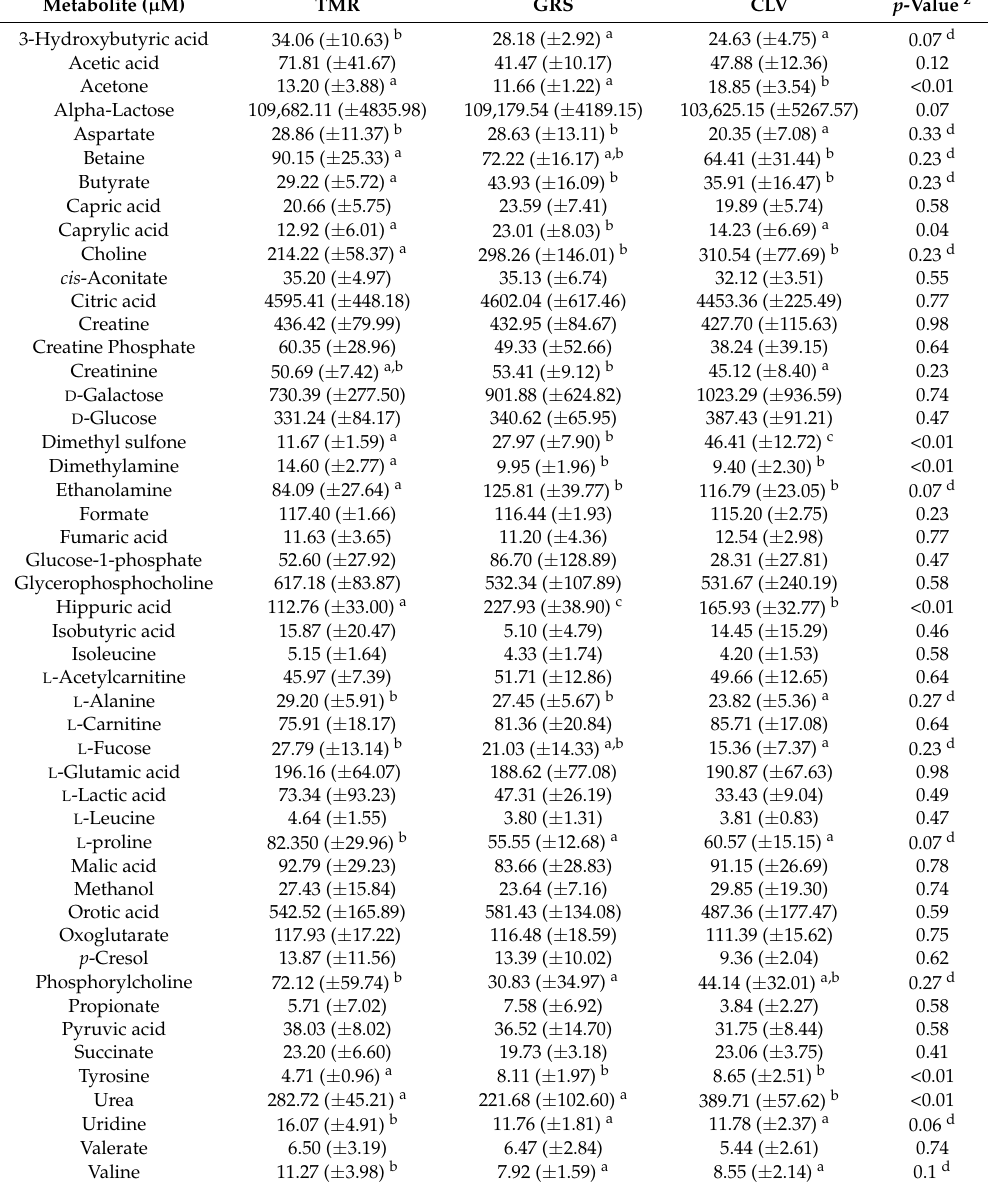
Table 5. Average concentrations (Mean ± standard deviation) of raw milk metabolites ( µ M) measured during mid-lactation from cows fed diets consisting of total mixed ration (TMR), perennial ryegrass (GRS), or perennial ryegrass and white clover (CLV), as determined by 1 H-NMR. Metabolite ( µ M) TMR GRS CLV p -Value